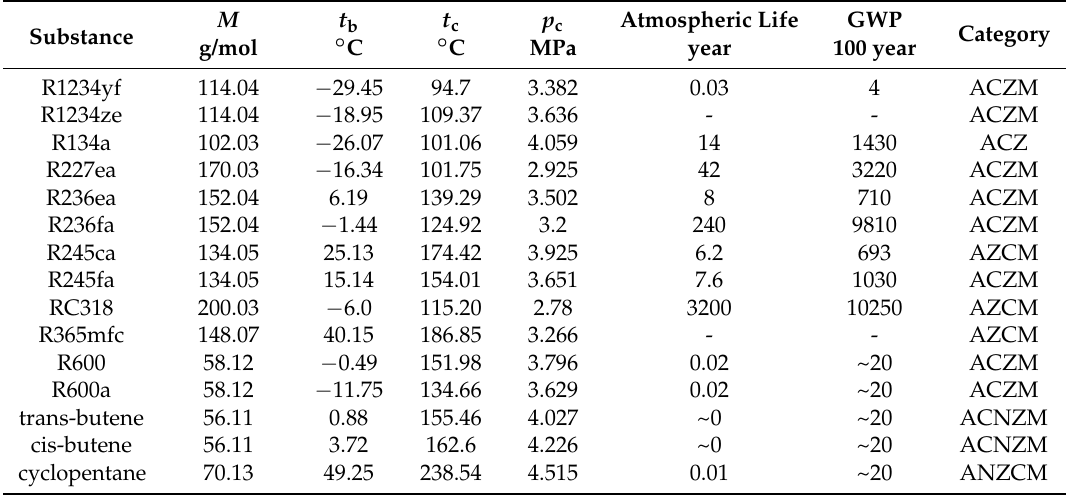
Table 1. The basic thermal properties and environmental properties of considered